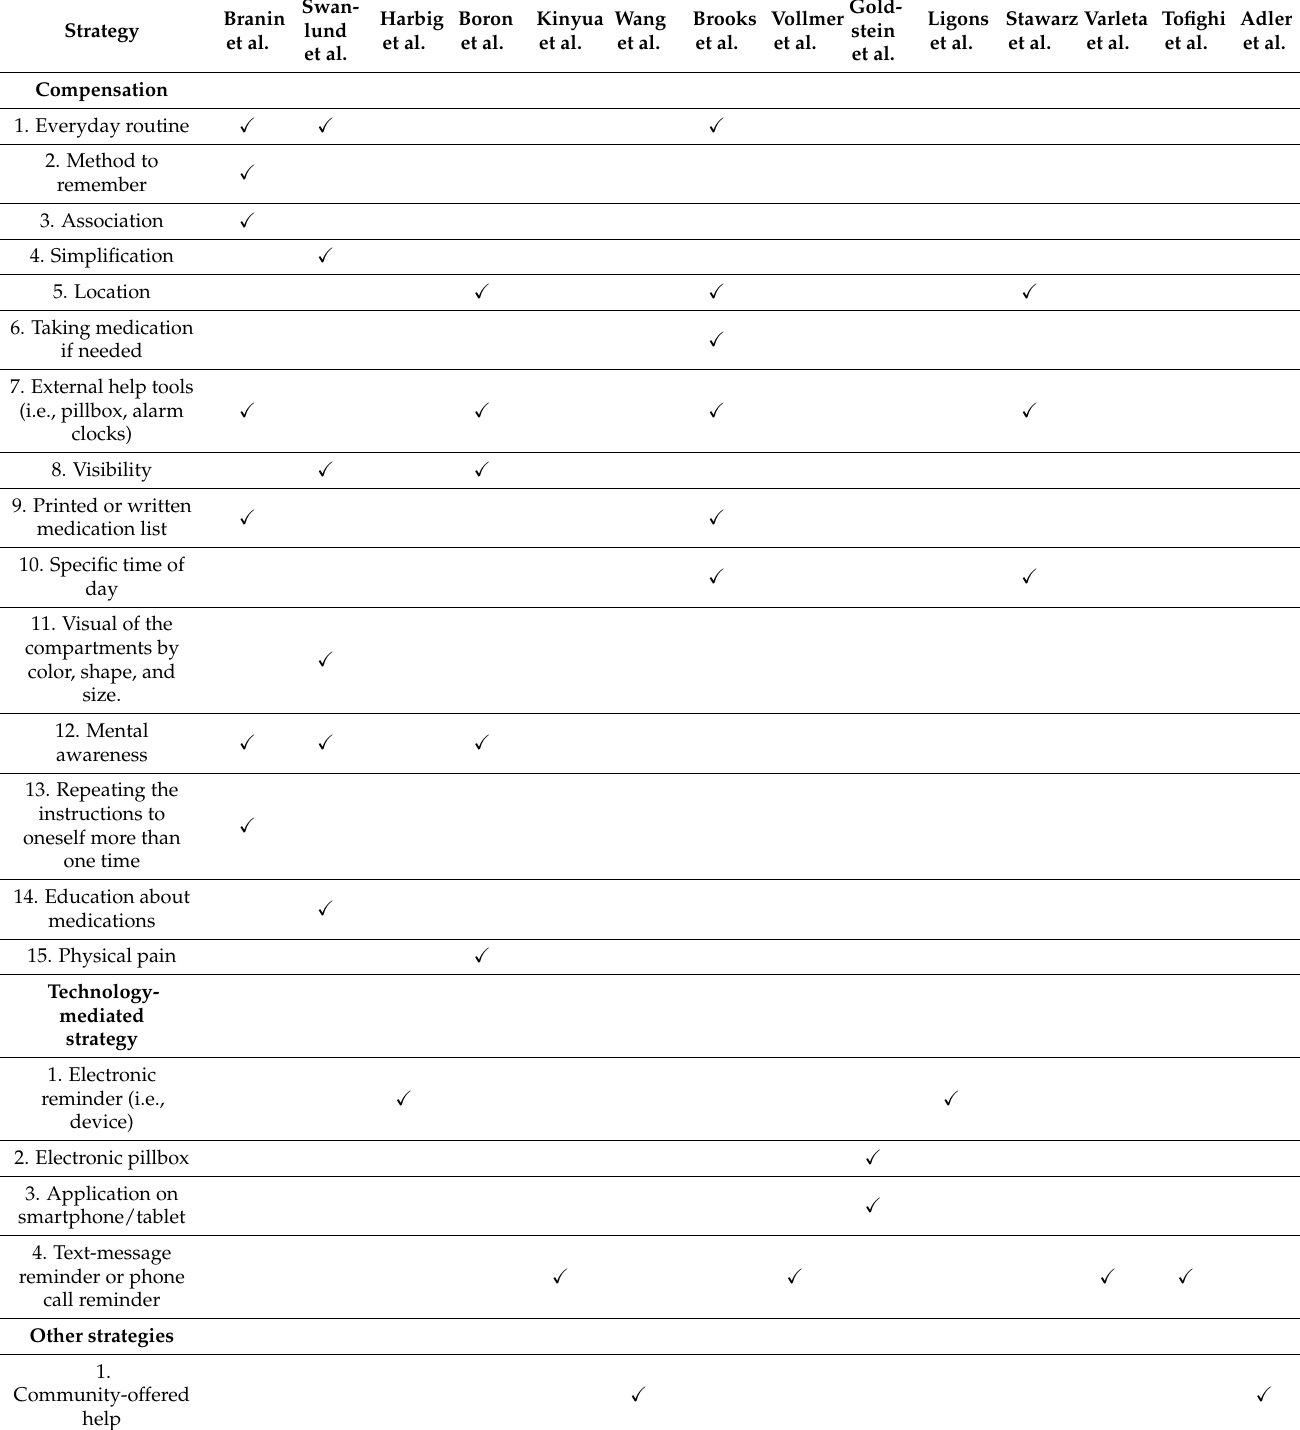
Table 2. Types of strategies used to enhance medication adherence.